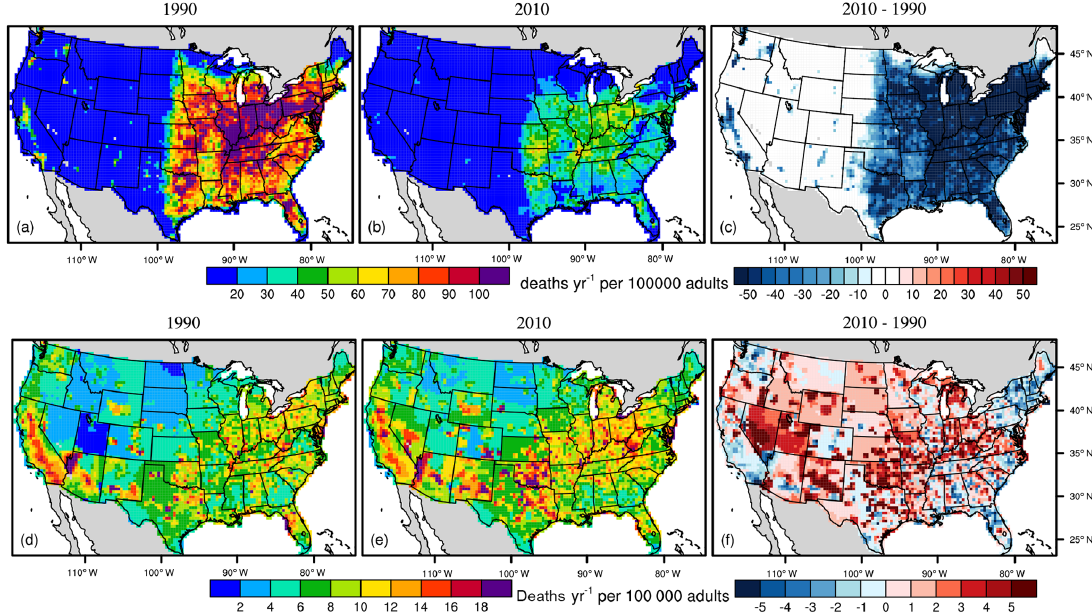
Figure 4. The mortality burdens associated with PM 2 . 5 (a, b) , O 3 (d, e) in 1990 (a, c) and 2010 (b, d) , and the differences (2010 minus 1990) (c, f) for each 36km × 36km grid cell. Units are deathsyear − 1 per 100000 adults (above 25 years